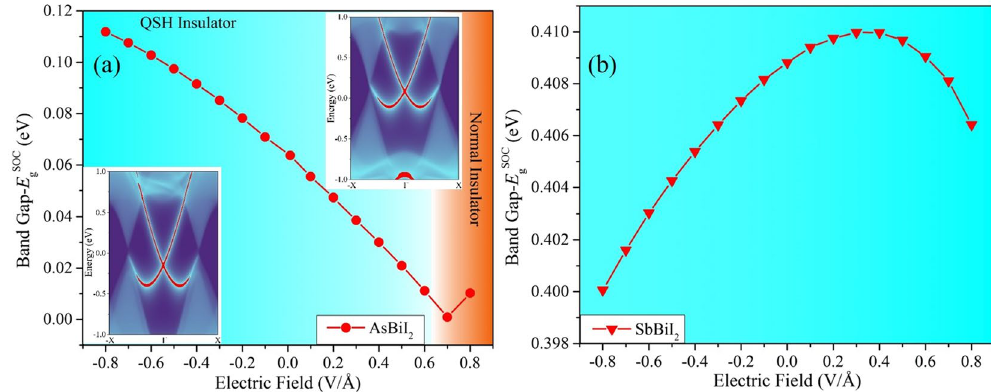
Figure 7. Variation of band gap ( E gSOC ) as a function of external electric field for ( a ) AsBiI 2 and ( b ) SbBiI 2 monolayers, respectively. The left and right inserts of ( a ) are LDOSs of edges at − 0.5 V/Å and 0.8 V/Å,